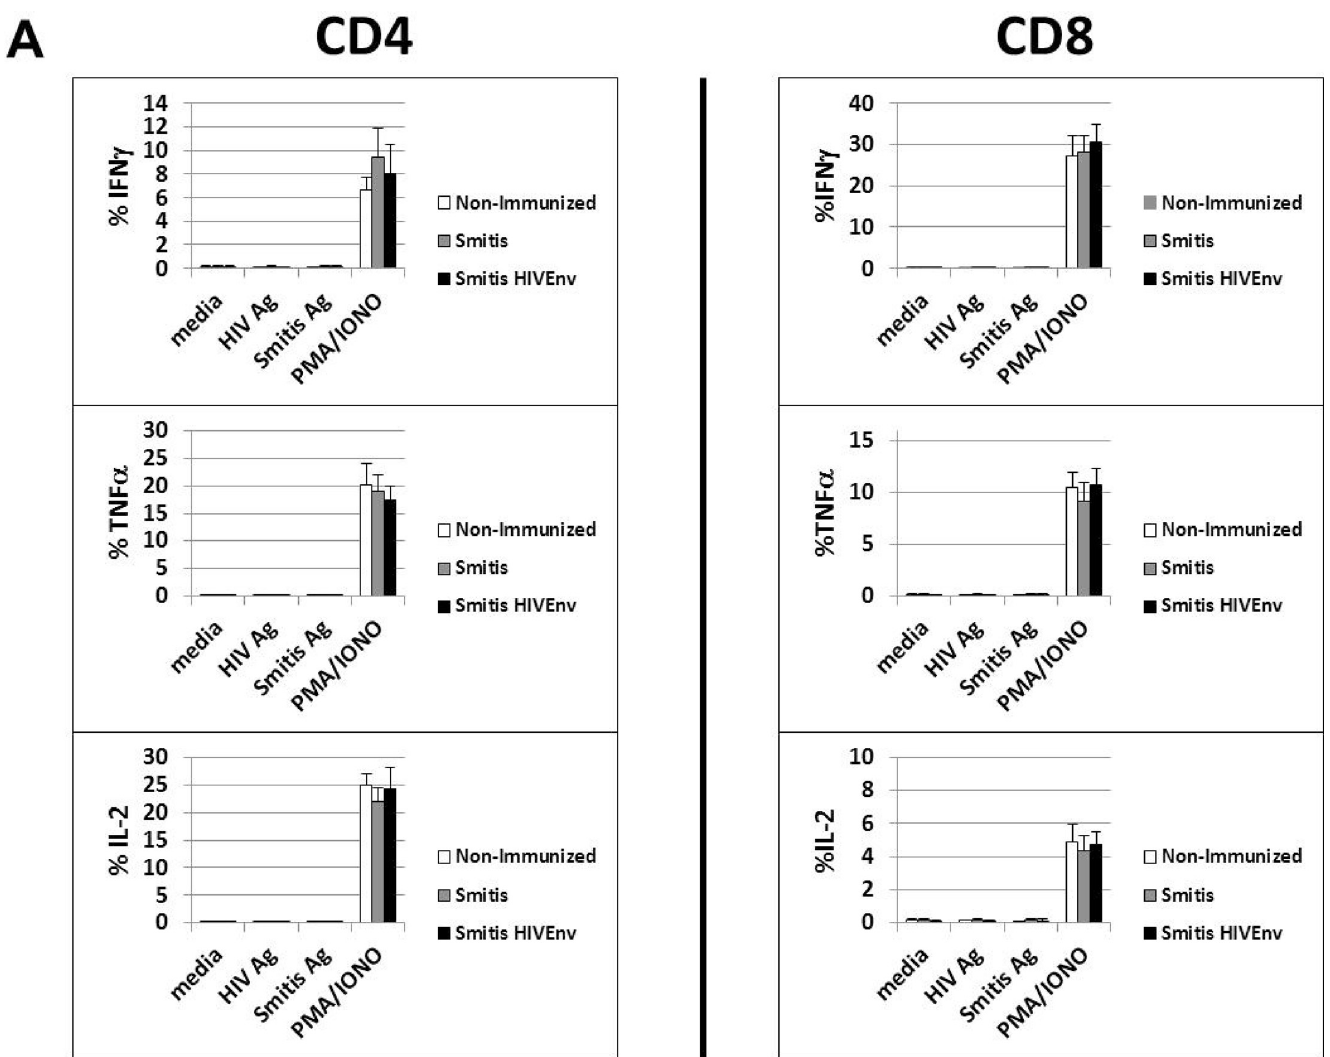
Fig 6. rS . mitis induces systemic T cell tolerance. (A) Germ-free mice were vaccinated orally with 10 9 cfu rS . mitis expressing HIV Env gp120 (Smitis HIV Env) or rS . mitis containing an integrated Erm r gene without Env gp120 (Smitis). Ten weeks later, peripheral blood monuclear cells were isolated from vaccinated mice and stimulated with media alone (media), S . mitis lysate antigens ( S . mitis Ag), the HIV Env gp120 protein (HIV Ag), or PMA and Ionomycin (PMA/IONO). Production of IFN γ , TNF α , and IL-2 by the stimulated cells measured by % IFN γ +, TNF α +, and IL-2+ CD4 or CD8 T cells from each group (3 mice/group) is shown. (B) To assess tolerance induction, germ-free mice were inoculated orally with 10 9 cfu to allow colonization and three months later, these mice were injected intraperitoneally (IP) with 2x10 8 cfu r S . mitis HIV Env (Balb/c (colonized) IP group). Non-colonized mice were either non-immunized (Non-immunized group) or inoculated IP with 2x10 8 cfu r S . mitis HIV Env (Balb/c IP group). Two weeks after intraperitoneal immunization of the colonized and non-colonized mice, the spleen and mesenteric lymph nodes (MLN) were harvested and stimulated in vitro with media, 10 μ g/ml purified HIV Env